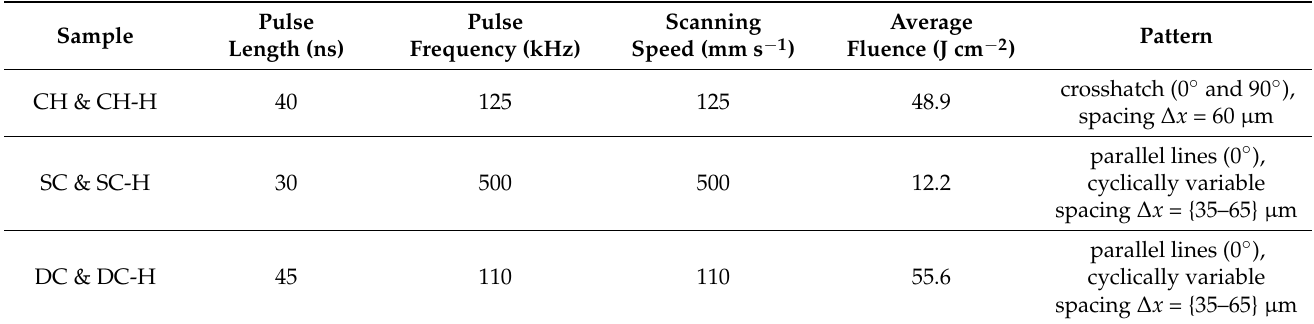
Table 1. Laser-texturing used to functionalize the copper